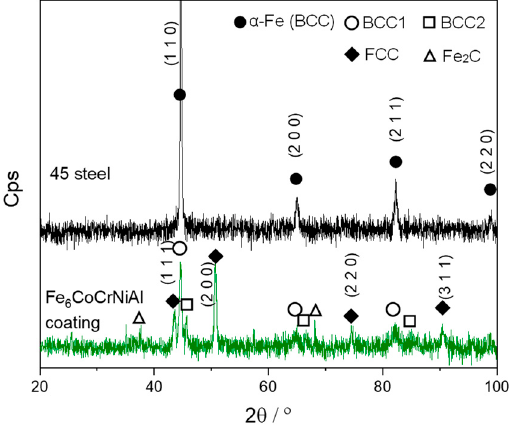
Figure 2. XRD pattern of 45 steel and Fe 6 CoCrNiAl coating.